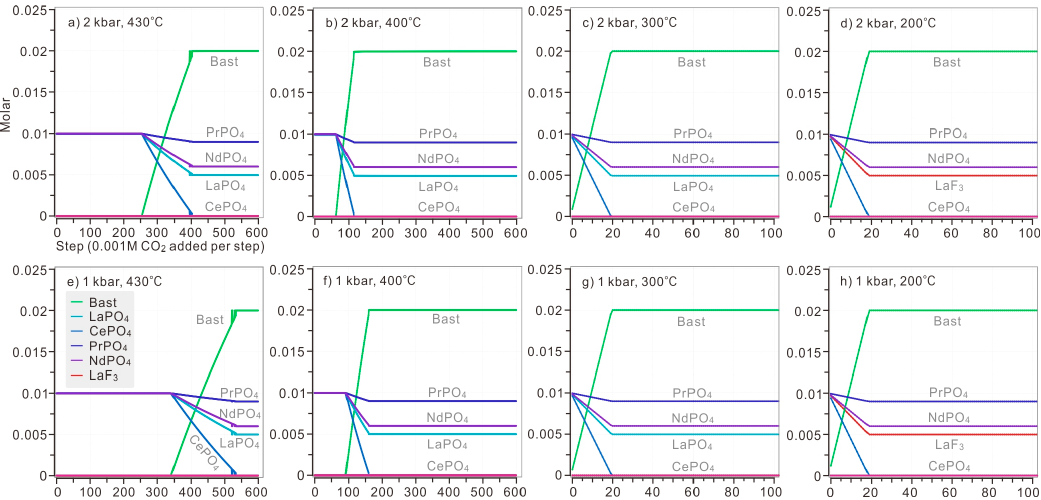
Figure 7. The replacement of bastnaesite by monazite when CO 2 (aq) was introduced stepwise (0.001 M CO 2 each step). The modelled solution contains 0.1 M HCl, 0.1 M HF, 0.1 M H 3 PO 4 , 0.1 M LaCl 3 , 0.1 M CeCl 3 , 0.1 M PrCl 3 , 0.1 M NdCl 3 , and 0.001 M–0.6 M CO 2 . The calculation was conducted on diverse temperature (ranging from 430 ◦ C to 200 ◦ C) and pressure (ranging from 2 kbar to 1 kbar). The P-T condition of each plot: ( a ) 2 kbar, 430 ◦ C; ( b ) 2 kbar, 400 ◦ C; ( c ) 2 kbar, 300 ◦ C; ( d ) 2 kbar, 200 ◦ C; ( e ) 1 kbar, 430 ◦ C; ( f ) 1 kbar, 400 ◦ C; ( g ) 1 kbar, 300 ◦ C; ( h ) 1 kbar, 200 ◦